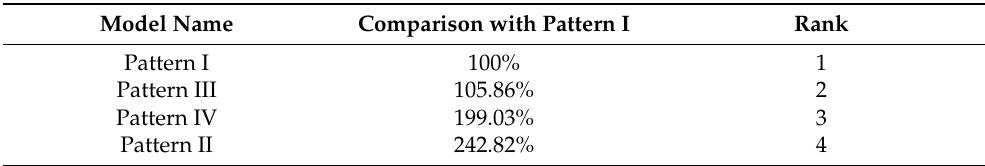
Table 11. Cross-sectional ranking based on Pattern I for a 2 MB